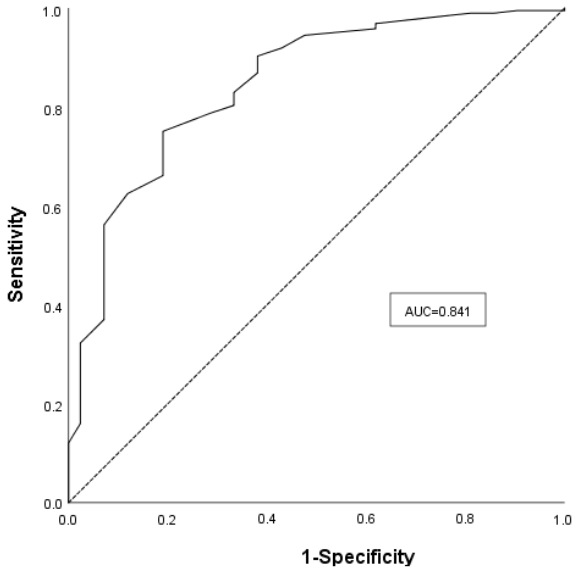
Figure A1. Receiver Operating Characteristic (ROC) curve. Abbreviation: AUC = area under the curve.